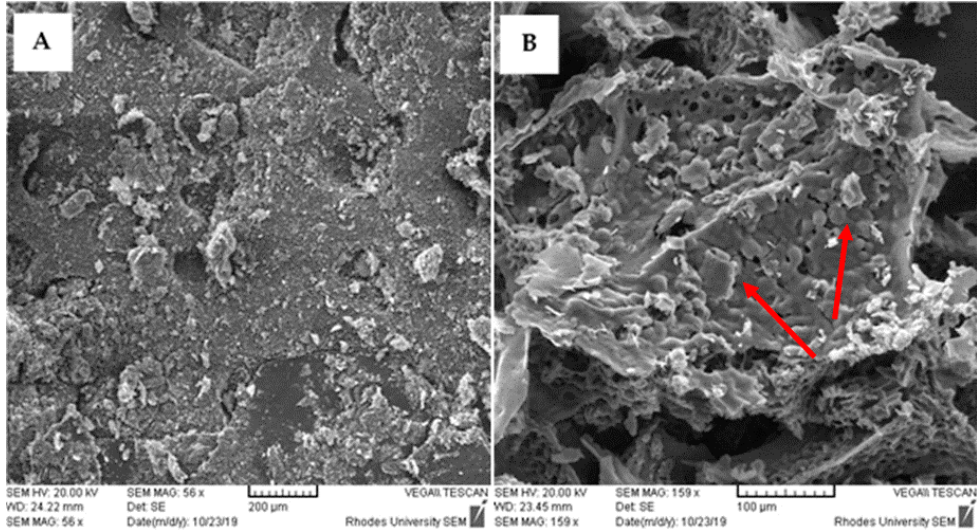
Figure 1. SEM images of ( A ) drug free hydrogel after lyophilization (magnification 56×) and ( B ) nano co-crystal (NCC)-loaded hydrogel/after lyophilization (magnification 159×).